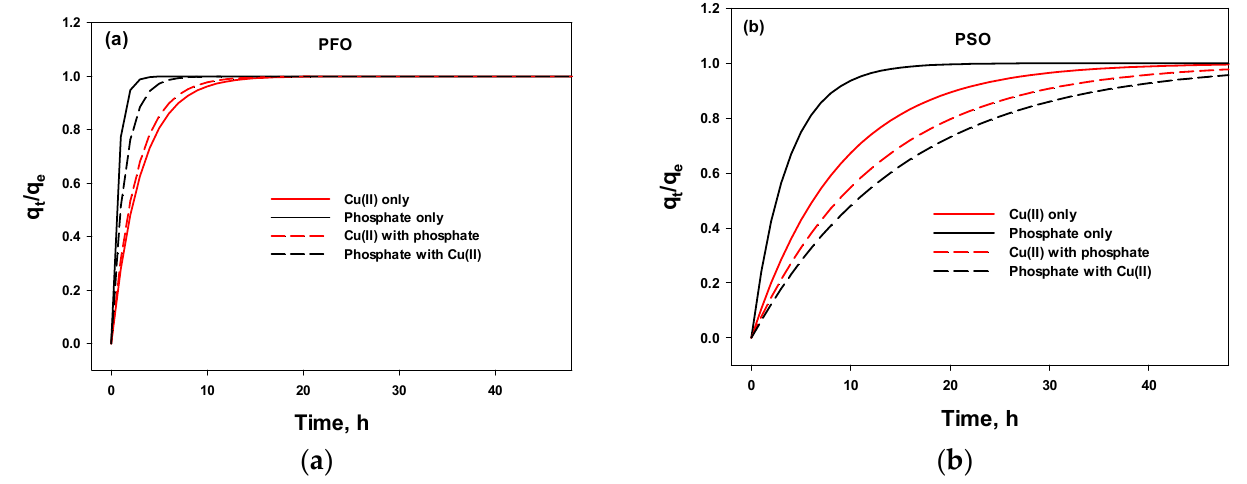
Figure 7. Plots of q t / q e versus time using pseudo-first-order (PFO) ( a ) and pseudo-second-order (PSO) kinetic models ( b ). Table 4. Comparison of equilibrium time for different conditions and